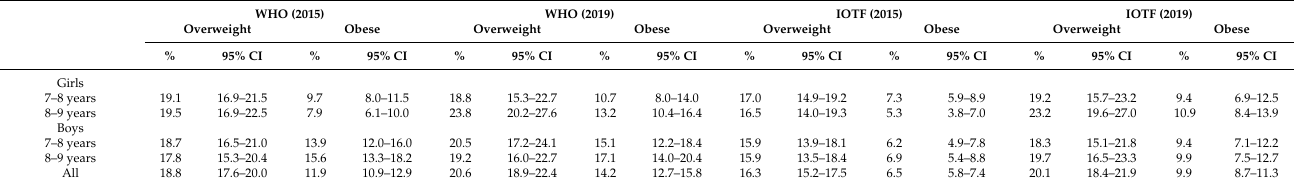
Table 2. Prevalence of overweight and obesity among Serbian children aged 7–9 years in national COSI round 1 (2015) and 2 (2019) using the WHO and IOTF